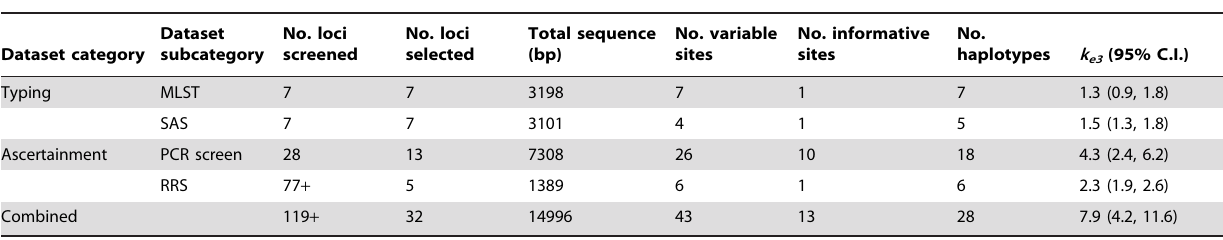
Table 1. Summary of genetic variation detected by different datasets.